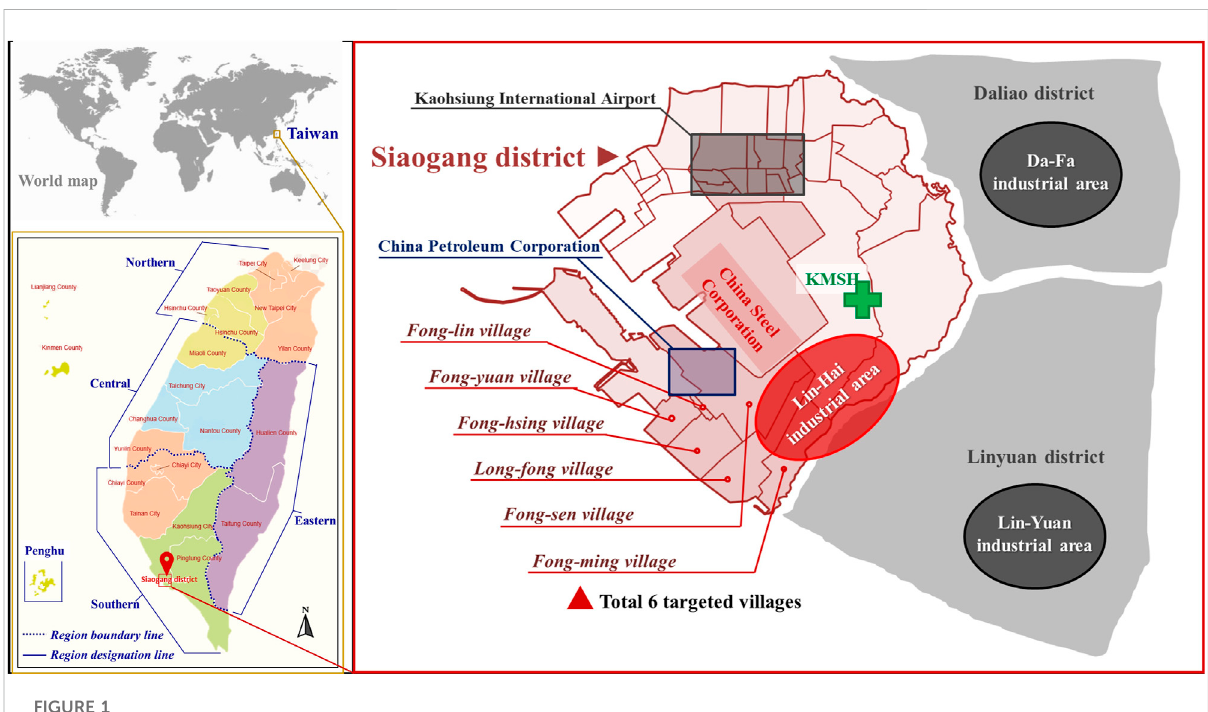
FIGURE 1 Maps of six villages close to one coastal heavy-industrial area (Lin-Hai industrial area) in southwestern Kaohsiung, Taiwan. KMSH: Kaohsiung Municipal Siaogang